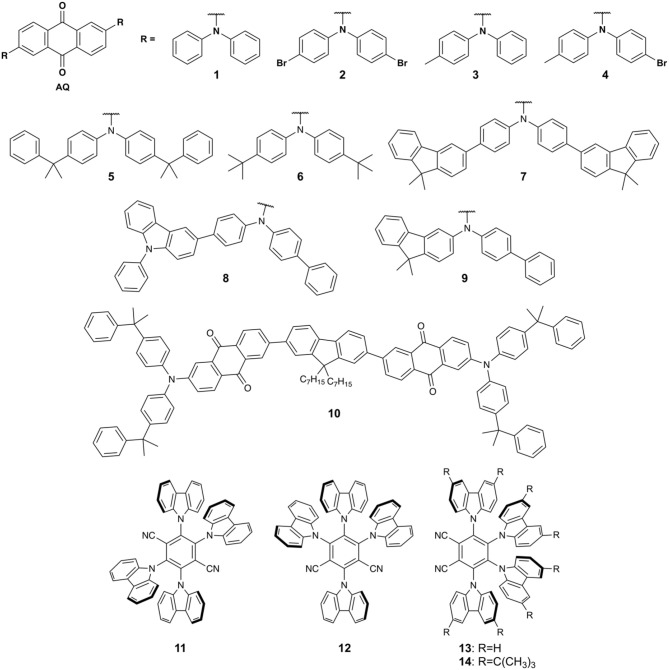
Structures of TADF compounds used by Borisov and coworkers to prepare thin films for oxygen and temperature sensing (Steinegger et al., 2017).